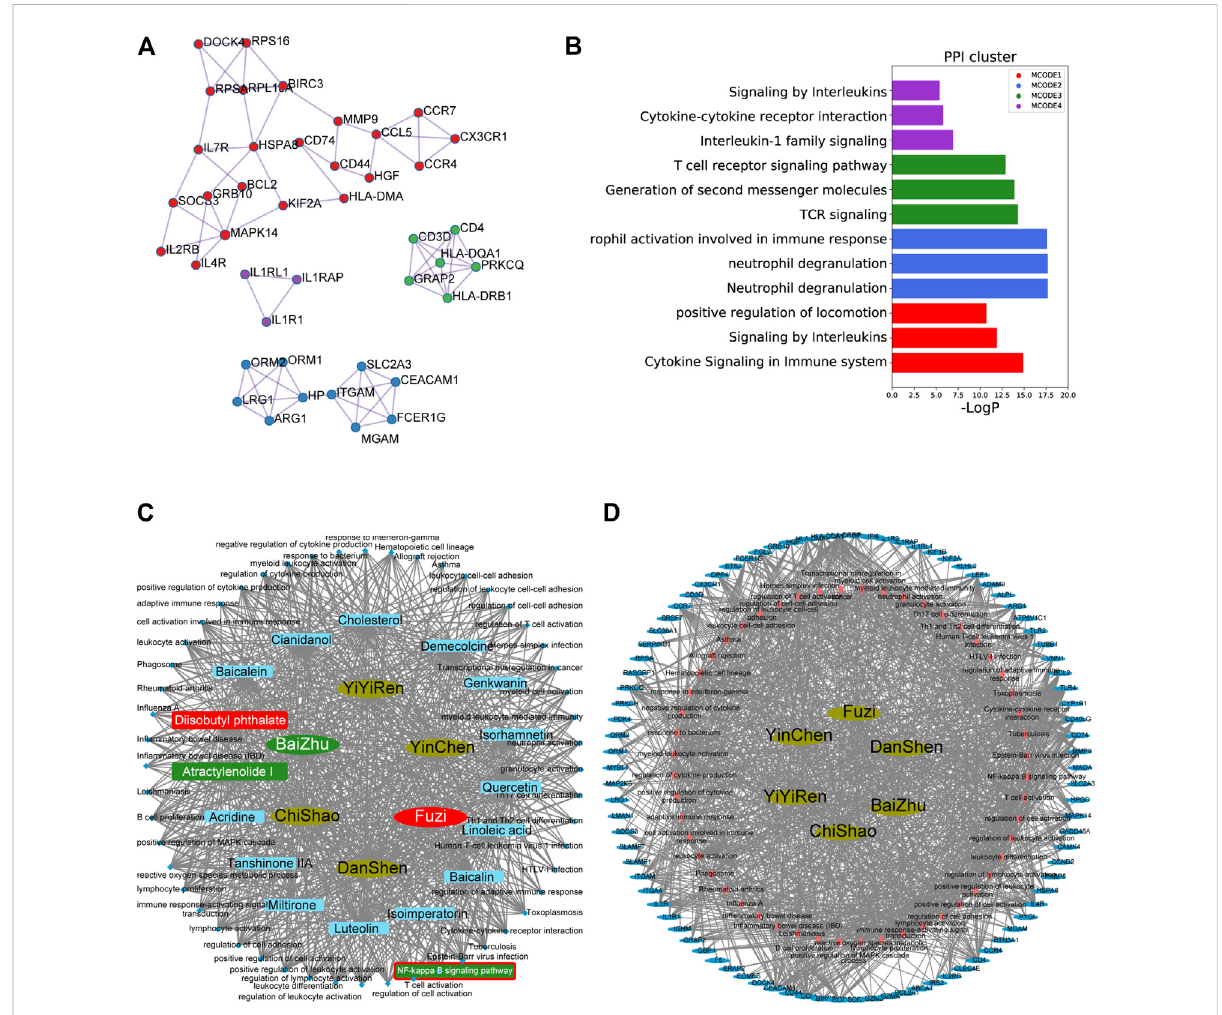
FIGURE 3 Herb – compound – signaling and herb – signaling – target networks. (A – B) Protein – protein interaction (PPI) analysis performed on 105 hub genes using STRING (https://string-db.org/cgi/input.pl) with physical score > 0.132. (C – D) Herb – compound – signaling (C) and herb – signaling – target networks (D) were constructed by